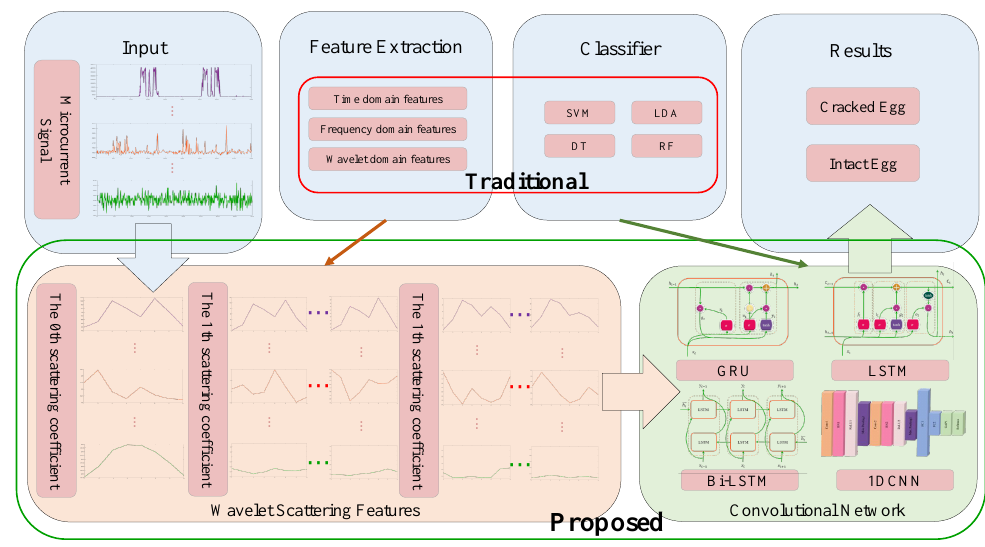
Figure 4. Research ideas for a non-destructive detection algorithm based on electrical characteristics of microcracks.